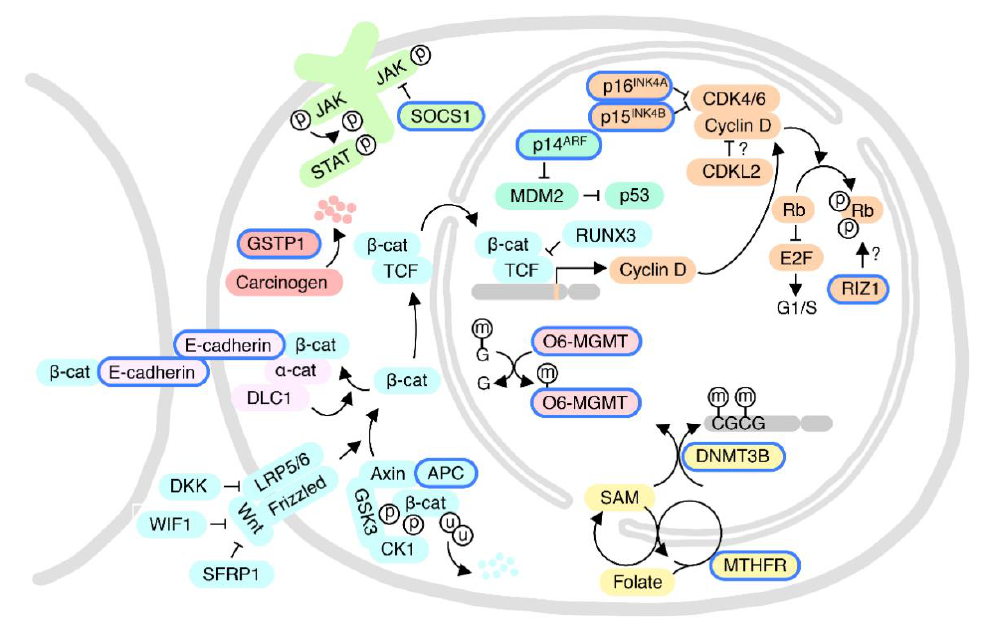
Figure 5. Cellular pathways implicated in race/ethnicity-related DNA methylation changes in HCC. Proteins regulated by race/ethnicity-related DNA methylation are highlighted by blue margins.